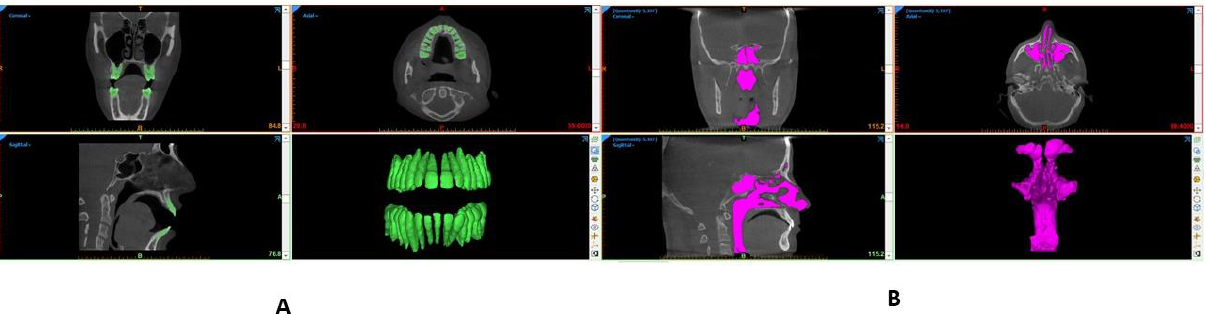
Figure 6. Example of digital segmentation of anatomical structures obtained from CBCT scans. ( A ), Tooth; ( B ), upper